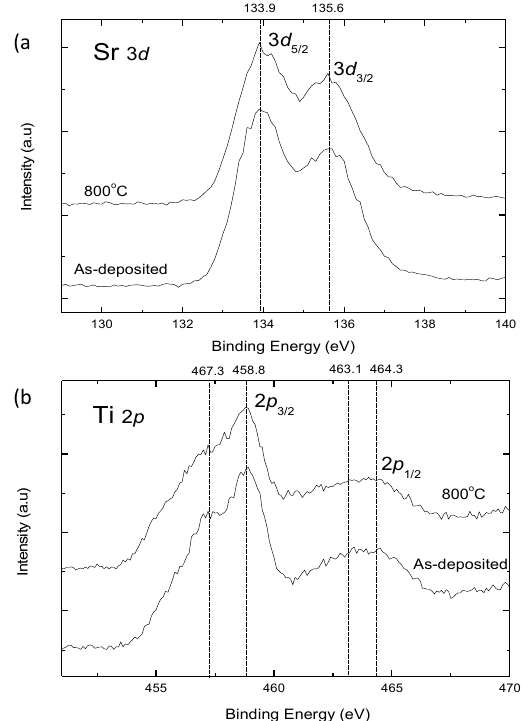
Figure 3. Depth profiles of the SrTiO 3 films ( a ) as-deposited and ( b ) annealed at 800 °C.